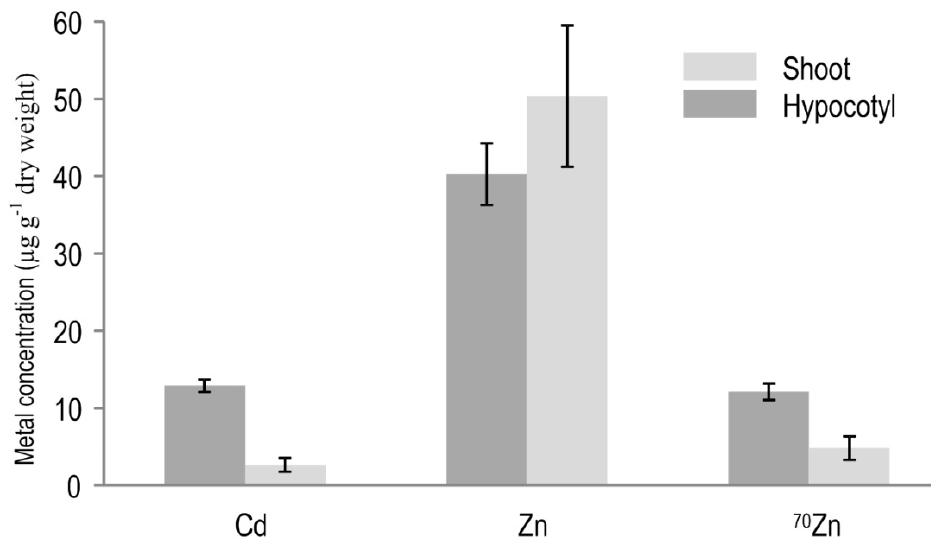
Figure 1. ICP-MS measured concentration of total Cd, total Zn and 70 Zn in the bulk hypocotyl and shoot tissue of 18-day-old radish ( Raphanus sativus L. cv. Cherry Belle) after 24-h exposure of root system to the equimolar (2.2 µ M ) Cd/ 70 Zn treatment. Error bars represent ± SE (n = 3).